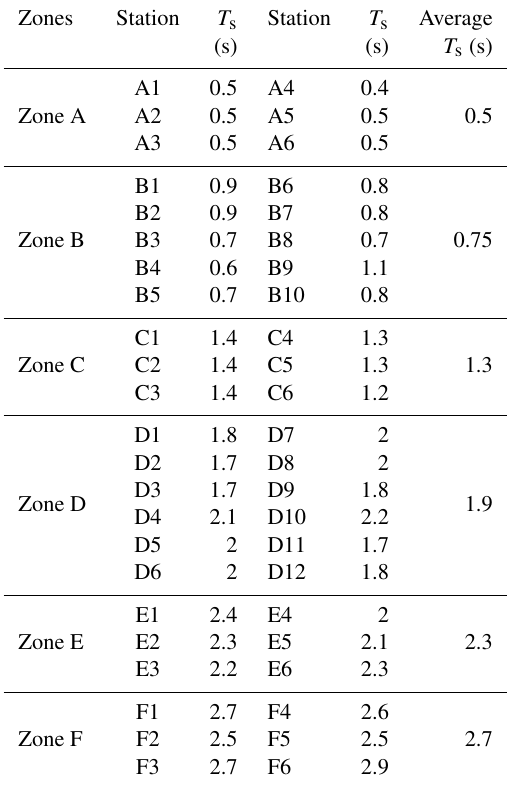
for CU (250-year return period). p Table 1. Zones of Mexico City grouped in accordance with the p dominant soil